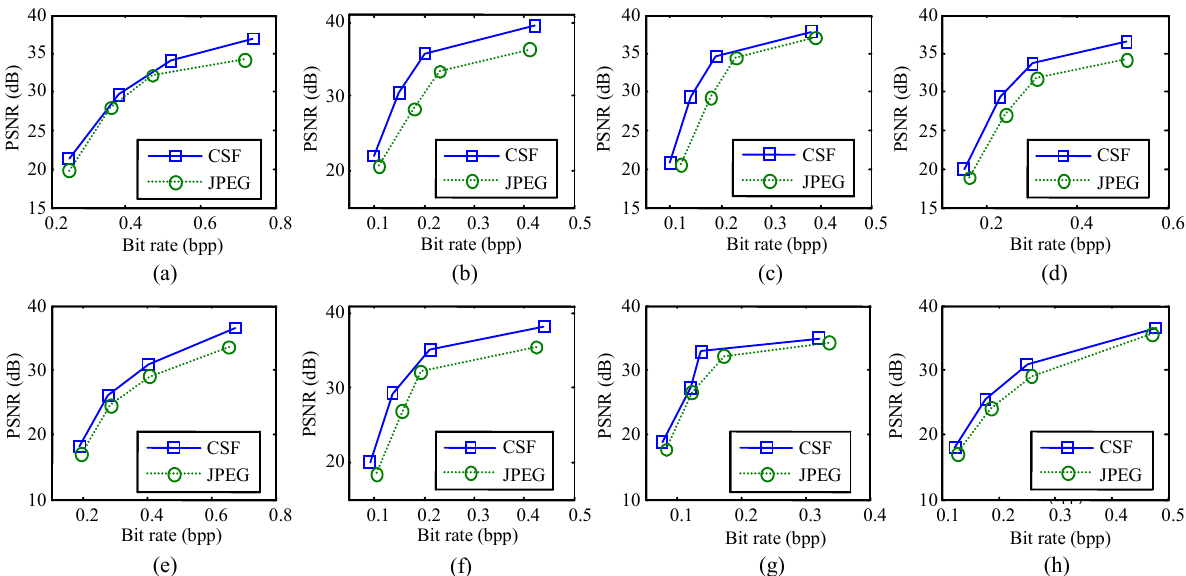
Fig. 7 Rate-distortion curves after the two color images being compressed by the JPEG and the proposed compression algorithm: (a) – ( d ) the rate-distortion curves of Y, C r , and C b components and color image for “Fruit” image, respectively and (e) – (h) the rate-distortion curves of Y , C r , and C b components and color image for the “Lena” image,